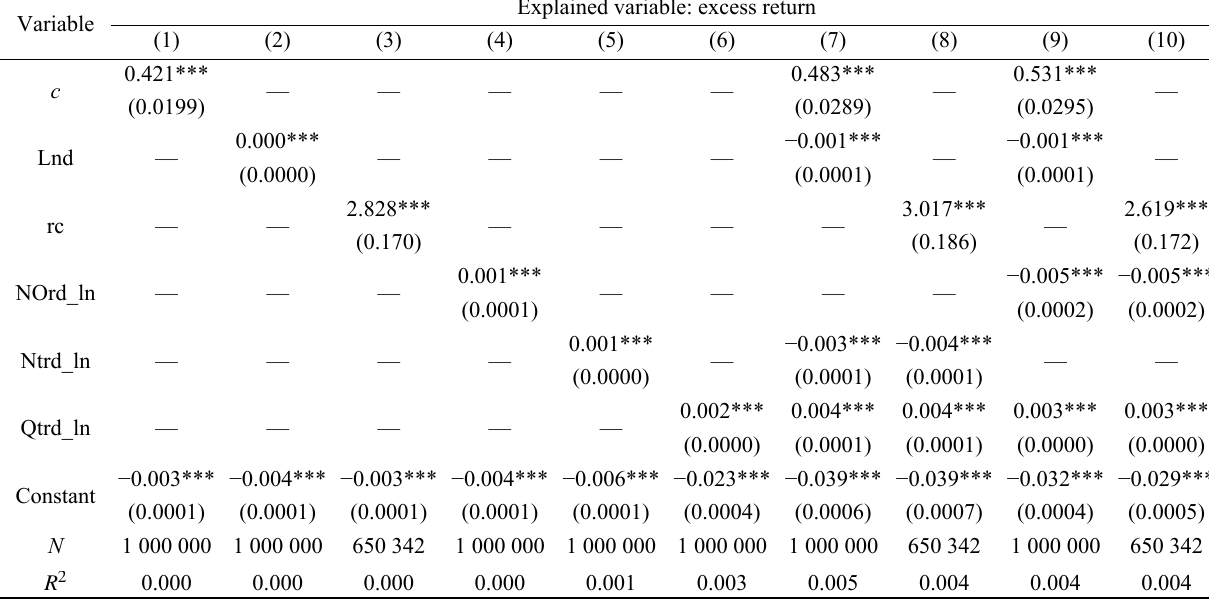
Table 4 Investors’ social network and excess